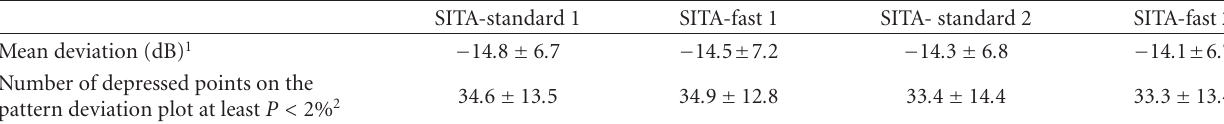
Table 1: Sensitivity parameters (mean ± SD) for each of the 10-2 tests, using 2 programs (SITA-standard and SITA-fast) in 2 separate visits.